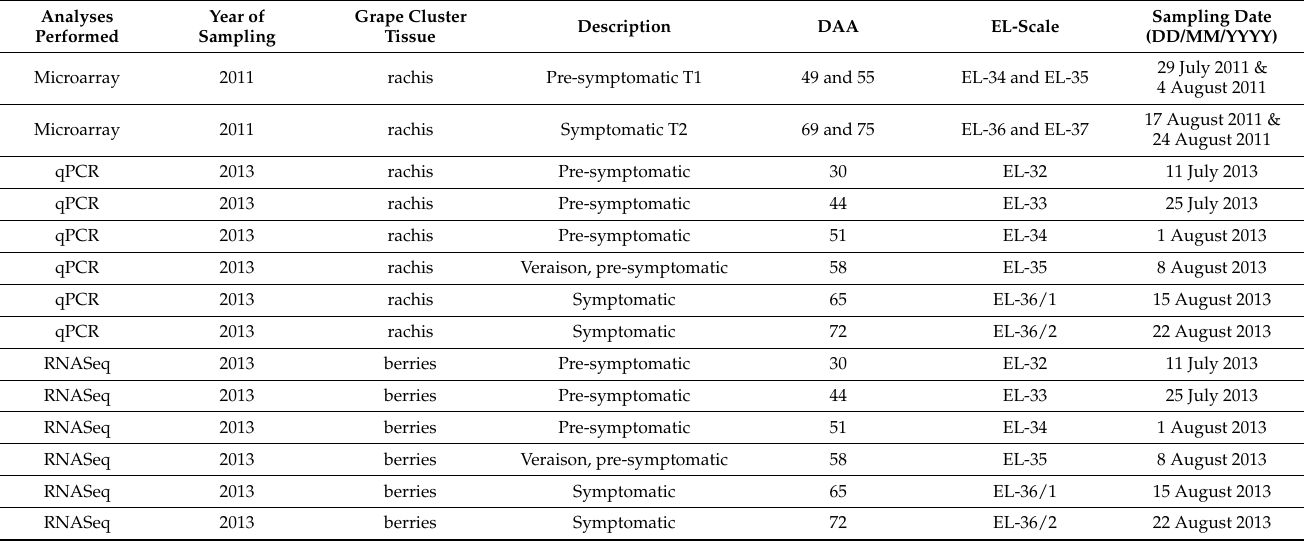
Table 2. Summary of samples used for expression analyses. Control (healthy) samples and BS-affected (BS) samples were analyzed in comparison at each sampling time point. All analyses were performed with three biological